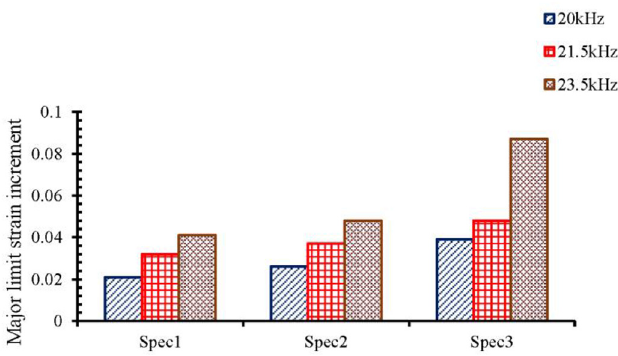
Fig. 11. Limit major strain increment of bulging-forming for three specimens under different frequencies.